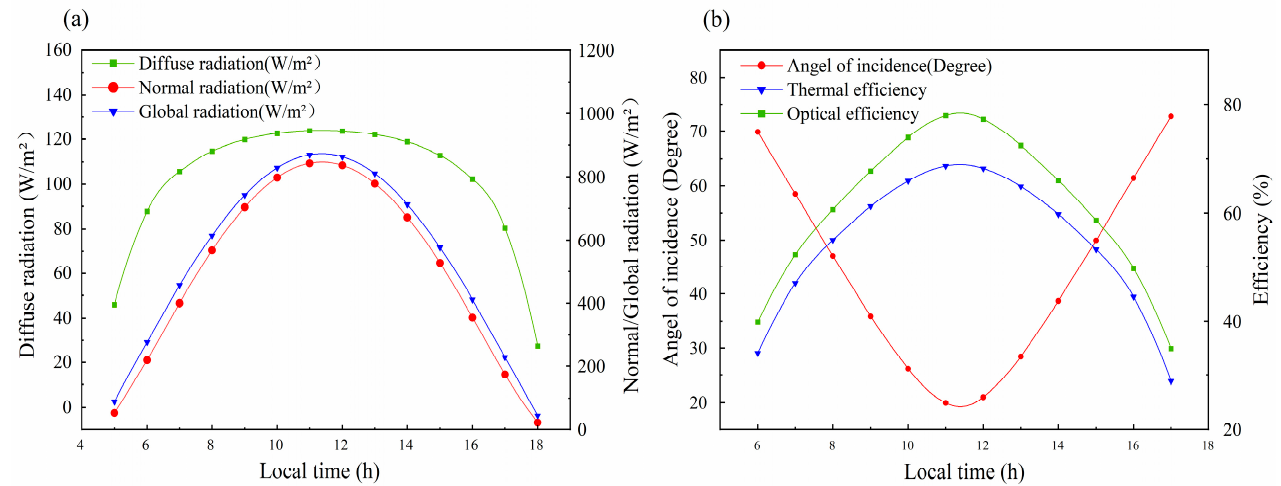
Figure 3. ( a ) Hourly solar radiation in Dunhuang; ( b ) hourly optical and thermal efficiency of PTC system.